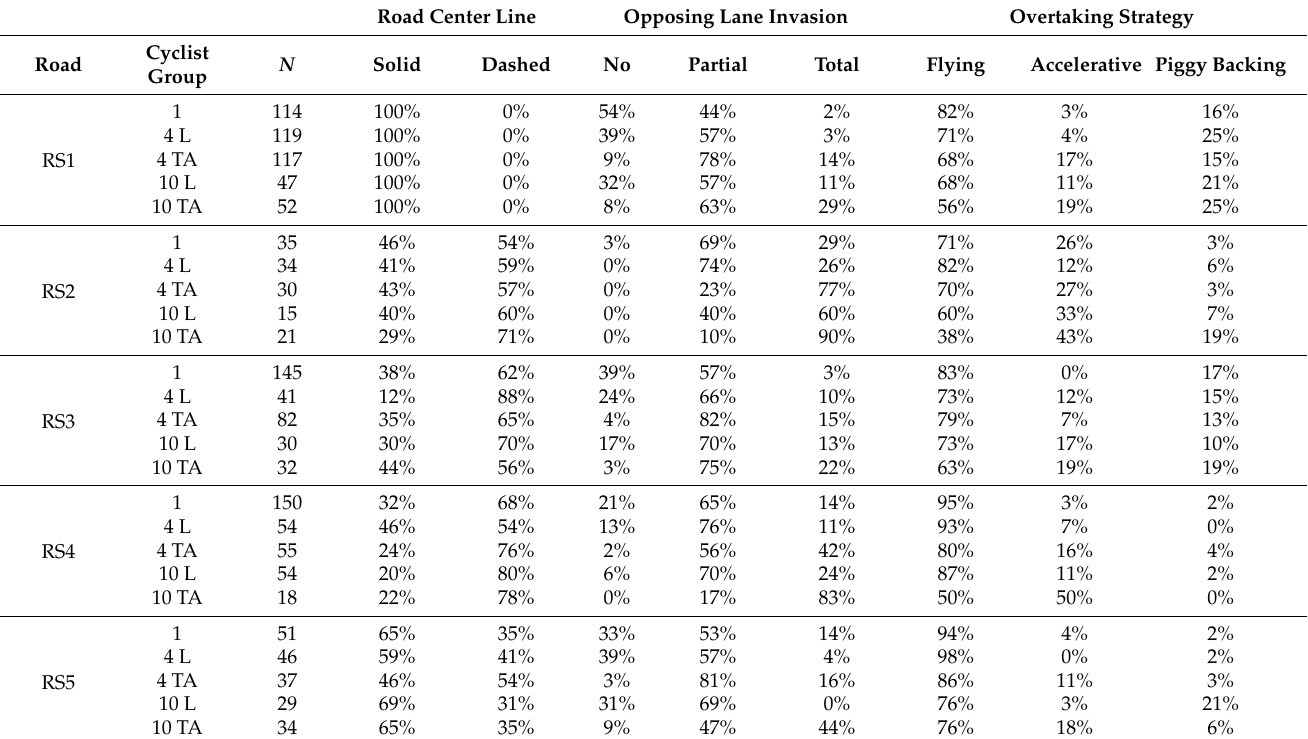
Table 6. Number of overtaking maneuvers recorded ( N ), and percentage of road center line type, opposing lane invasion, and overtaking strategy of overtaking maneuvers performed on each road segment and to each group of cyclists. Road Center Line Opposing Lane Invasion Overtaking